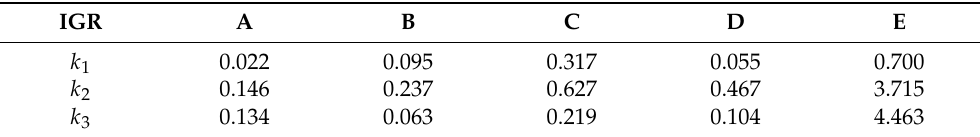
Table 4. IGR of each